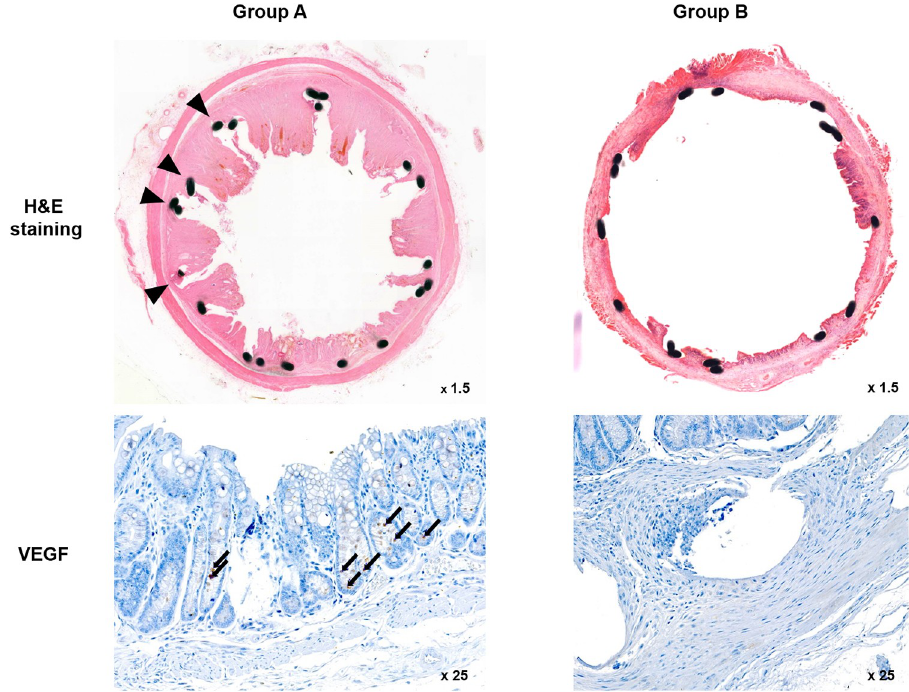
Fig 4. Representative microscopic images of histological sections and immunohistochemistry sections were obtained 4 weeks after stent placement. Hematoxylin and eosin (H&E) staining and VEGF immunohistochemistry. [Arrowheads = stent struts (magnification × 1.25), Arrows = VEGF-positive cells (magnification × 25)]. VEGF: Vascular endothelial growth factor.